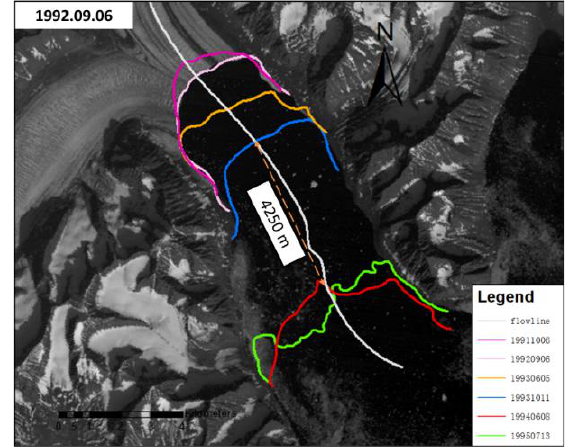
Figure 5 . Sortebræ Glacier, central East Greenland. Ice front location from October 6, 1991 (peony pink) to July 13, 1995 (medium apple) overlaid on Landsat ‐ 5 TM (bands 4). Dashed grey lines the central flowline.